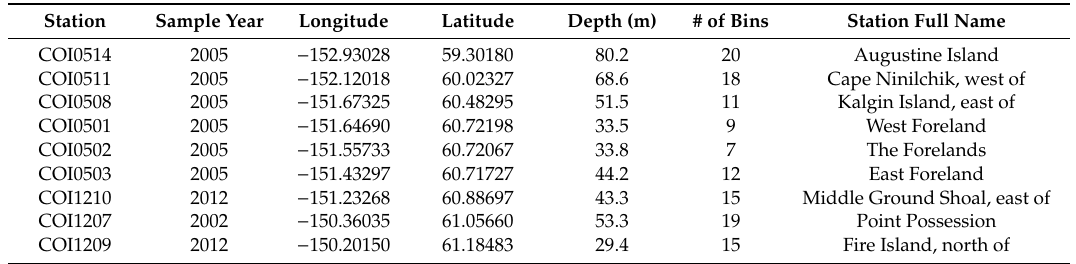
Table 1. The list of selected Acoustic Doppler Current Profilers (ADCP) stations for model-data comparisons.